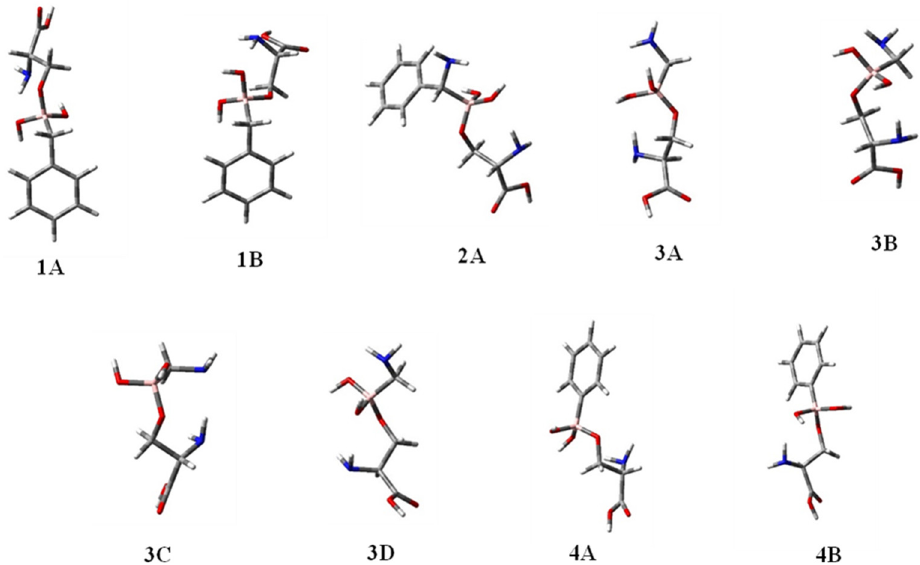
Figure 4. 3D-plots of the significantly populated conformers of compounds 1 – 4 located by DFT cal- culations.